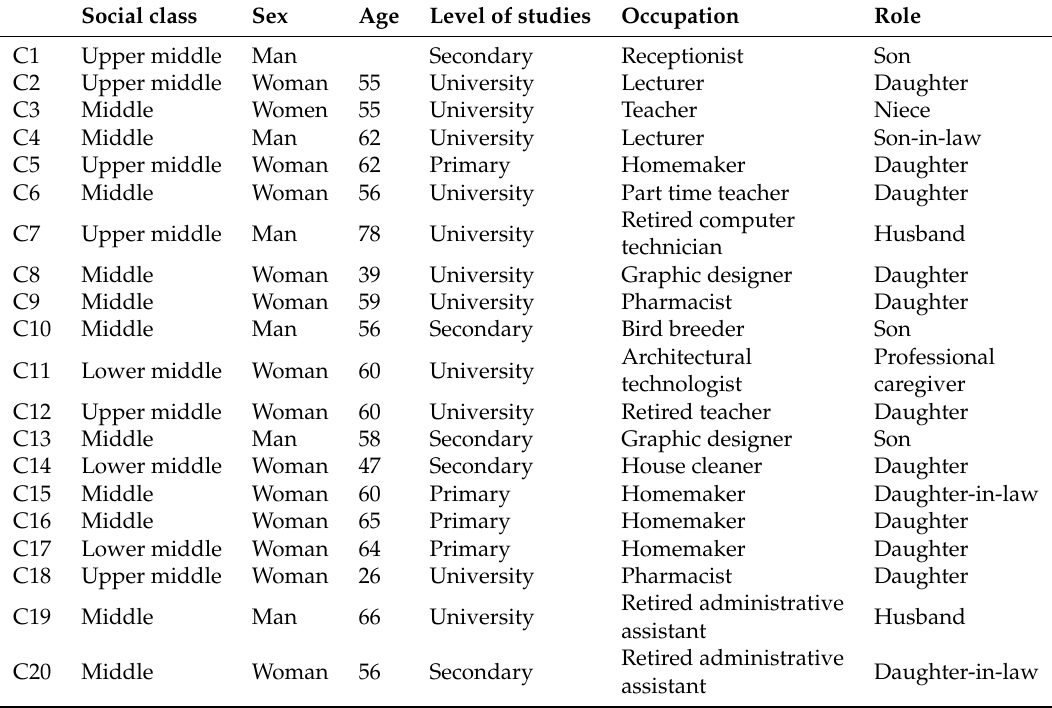
Table 1. Sociodemographic variables of dementia